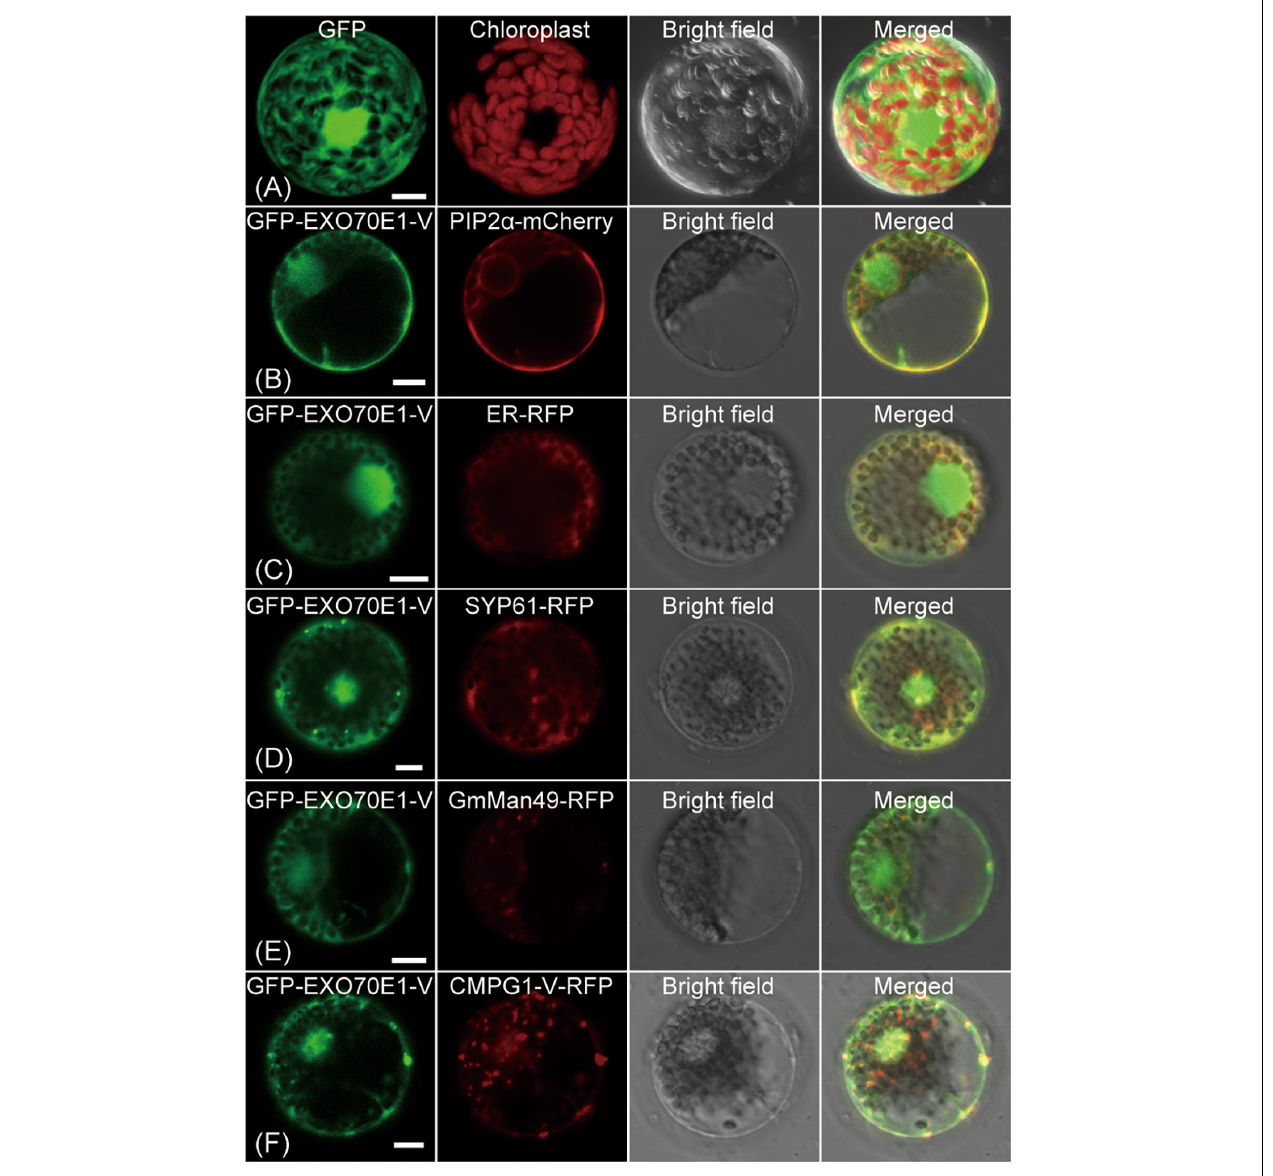
FIGURE 3 | Subcellular localization of GFP-EXO70E1-V and interaction of GFP-EXO70E1-V with CMPG1-V-YFP in wheat protoplast. (A) GFP control. (B) Co-localization of the constructs GFP-EXO70E1-V (in green) and PIP2 α –mCherry (in red, marker gene on plasma membrane). (C) Co-localization of the constructs GFP-EXO70E1-V (in green) and ER-RFP (in red, marker gene on endoplasmic reticulum). (D) Co-localization of the constructs GFP-EXO70E1-V (in green) and SYP61-RFP (in green, marker gene on trans-Golgi network/early endosome). (E) Co-localization of the constructs GFP-EXO70E1-V (in green) and GmMan49-RFP (in green, marker gene on Golgi). (F) Co-localization of GFP-EXO70E1-V (in green) and CMPG1-V-RFP (in red). Scale bar = 10 µ